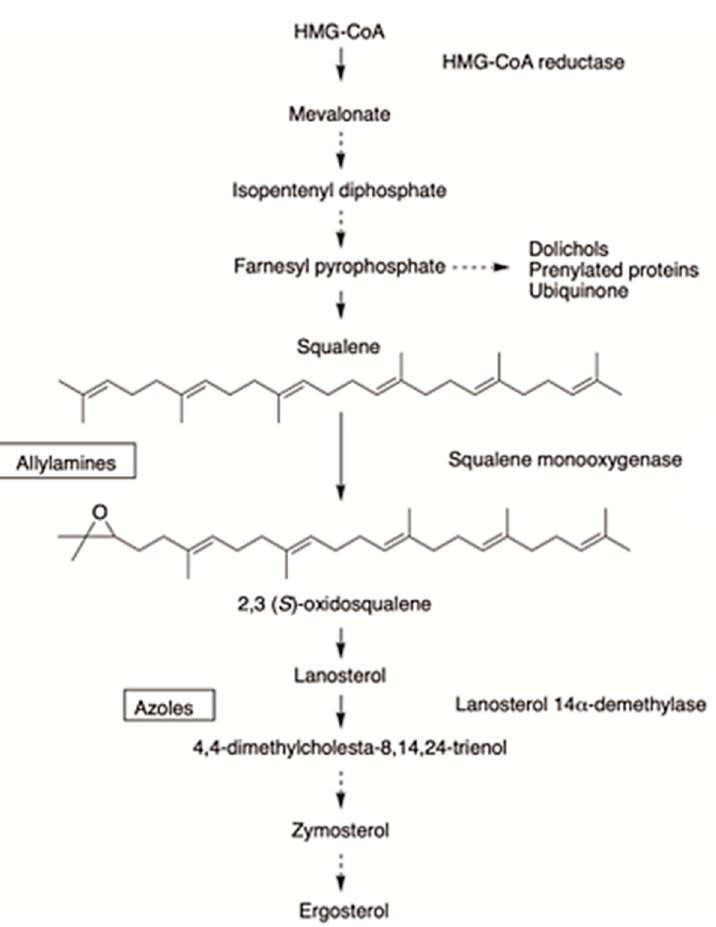
Figure 3. Ergosterol biosynthesis pathway in fungi [64]. The simple arrow indicates one catalytic step from the substrate to the product, and the dotted arrow represents the existence of several additional catalytic steps. The rectangular boxes show the site of action of allylamines and benzylamine on squalene epoxidase (squalene monooxygenase), which is distinct from the site of action of azoles.